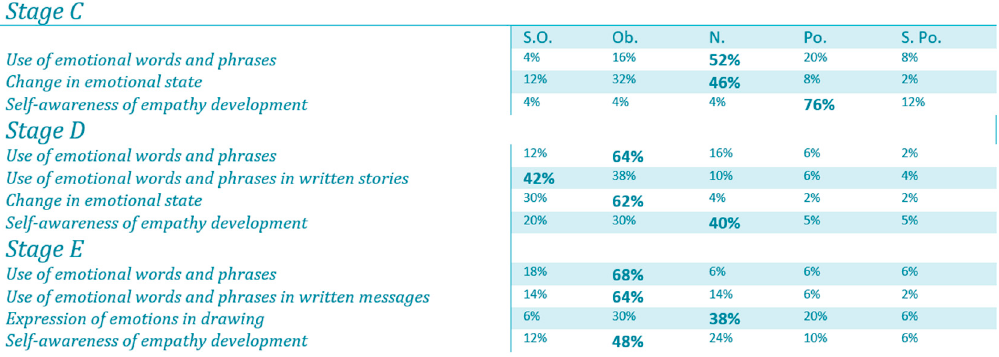
Figure 7. The percentages resulting from debriefing the rubric.